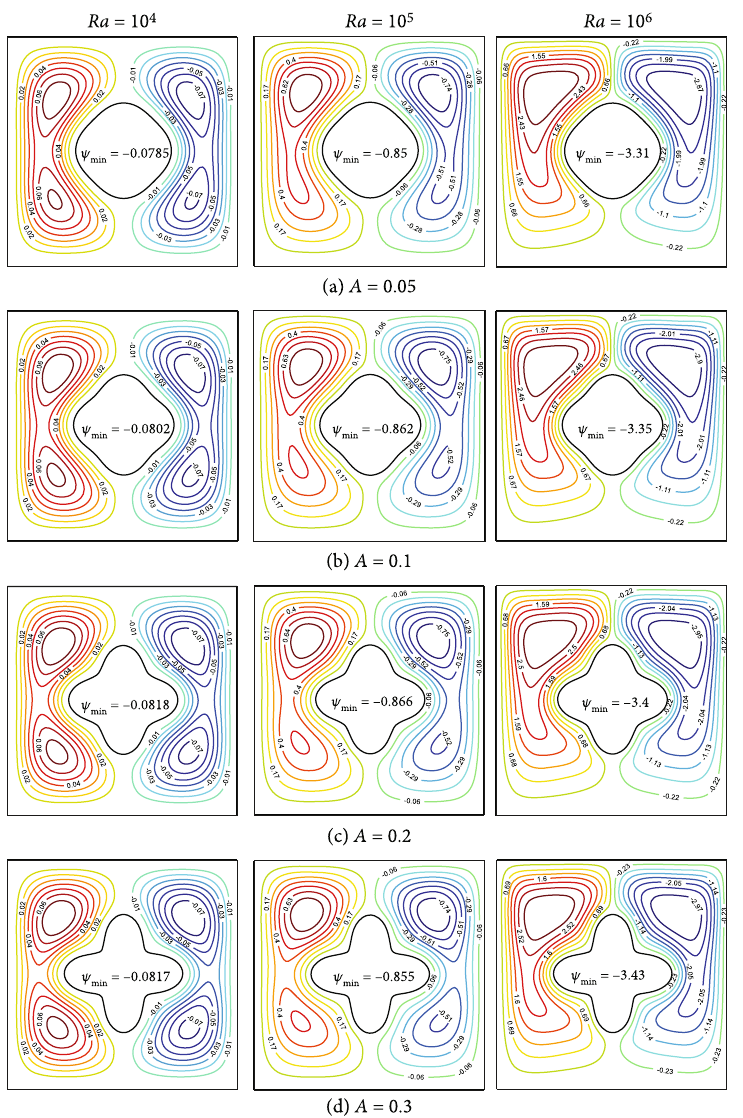
Figure 3: Streamlines for the combination of Rayleigh numbers and varying the amplitude corrugation, A at N = 4 and ϕ = 0 : 03